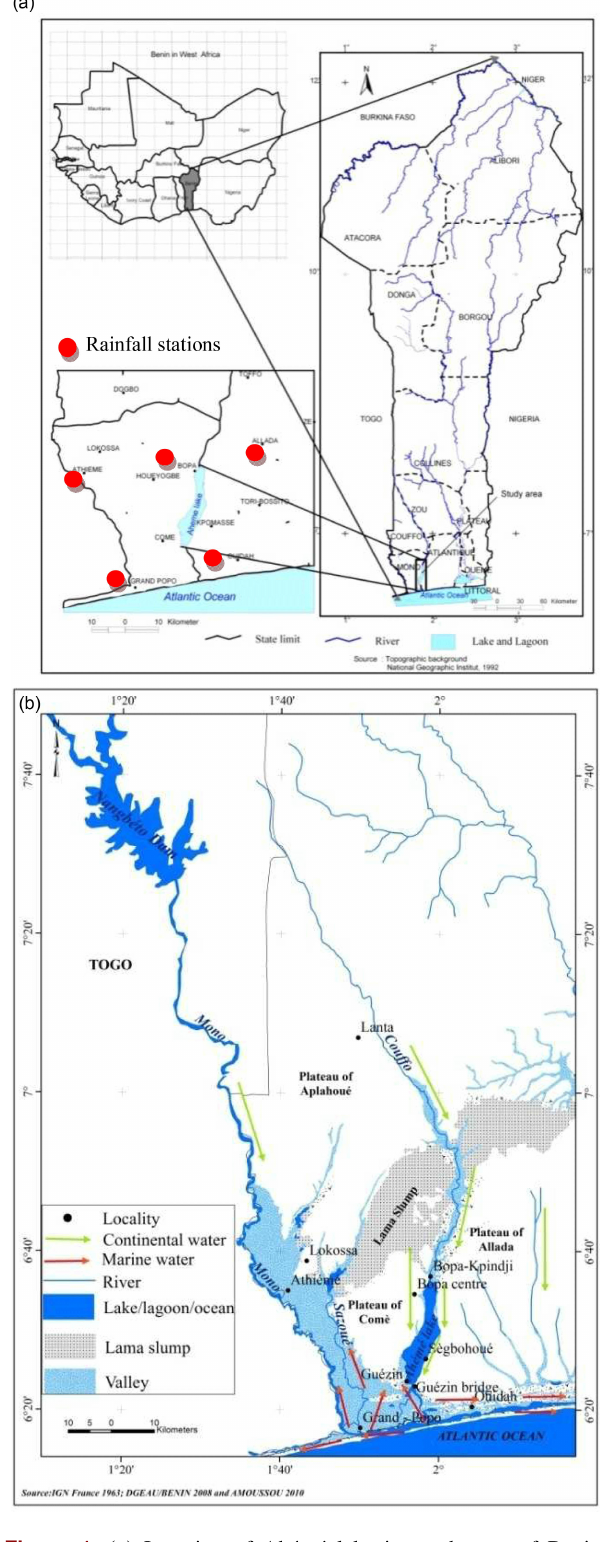
Figure 1. (a) Location of Ahémé lake in south-west of Benin. (b) The flow direction of the Mono-Couffo rivers and Ahémé